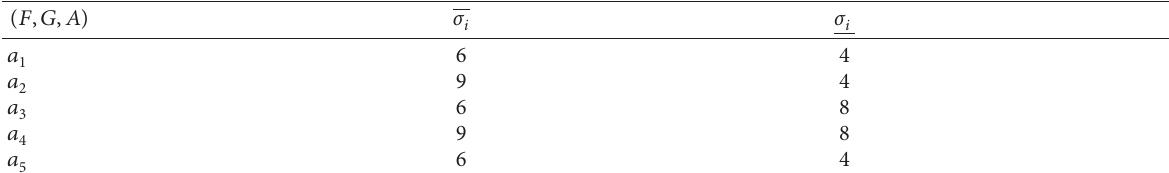
,a , a , a , a . 1 2 3 4 5